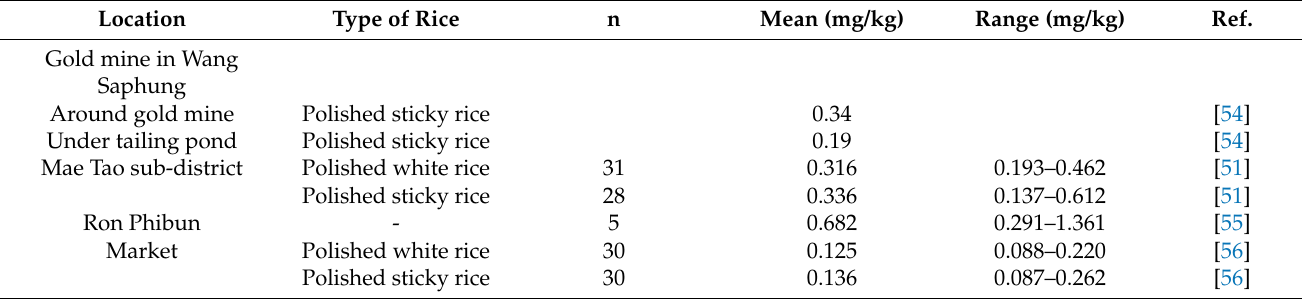
Table 3. Total arsenic concentration in rice samples from several regions in